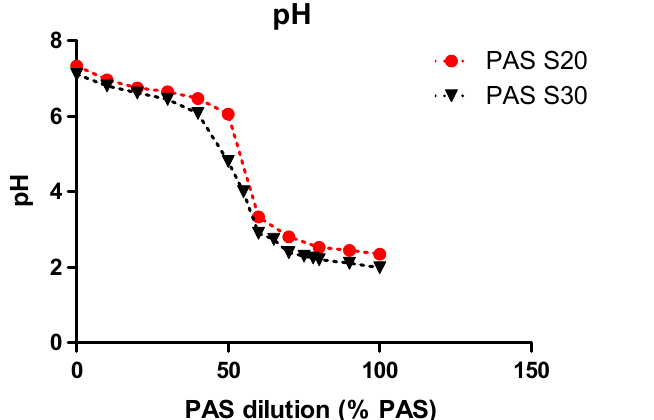
Figure 7. pH values of diluted PAS 20 and PAS